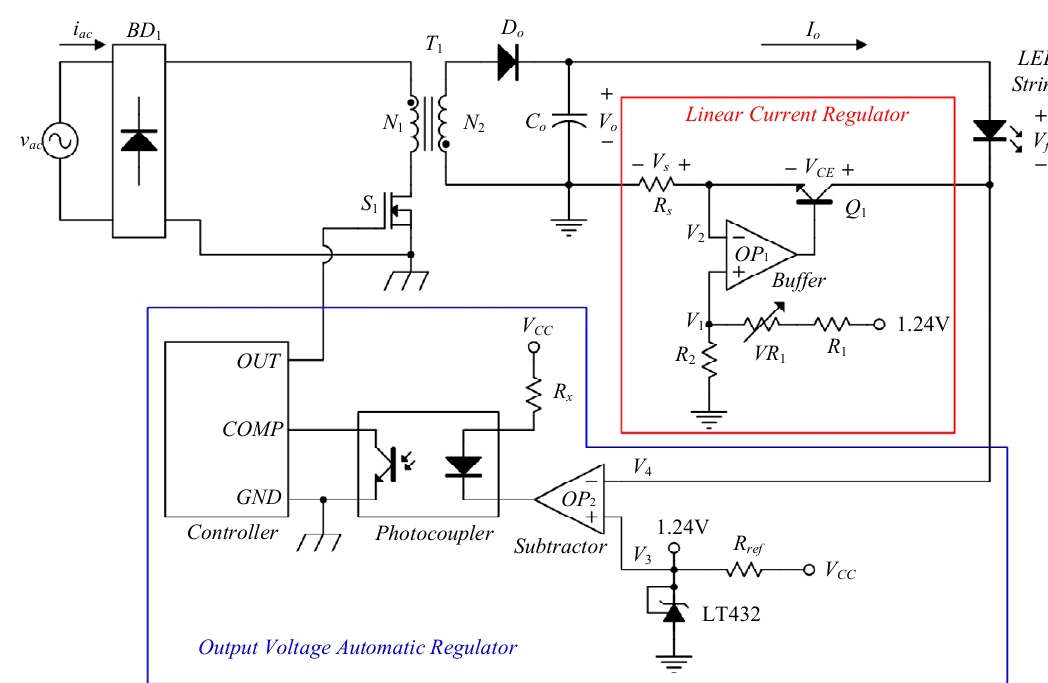
Figure 2. Brief illustration of the overall system for the proposed light-emitting diode (LED) driver.